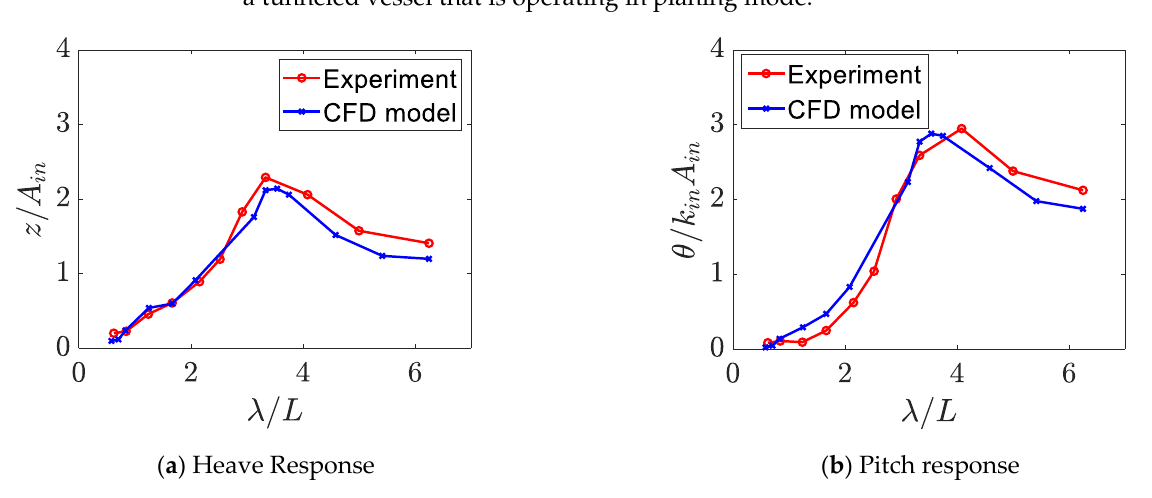
Figure 5. Heave and pitch responses of Model A. Circle and cross markers correspond to experimental and CFD data. Experimental data are presented in [42].